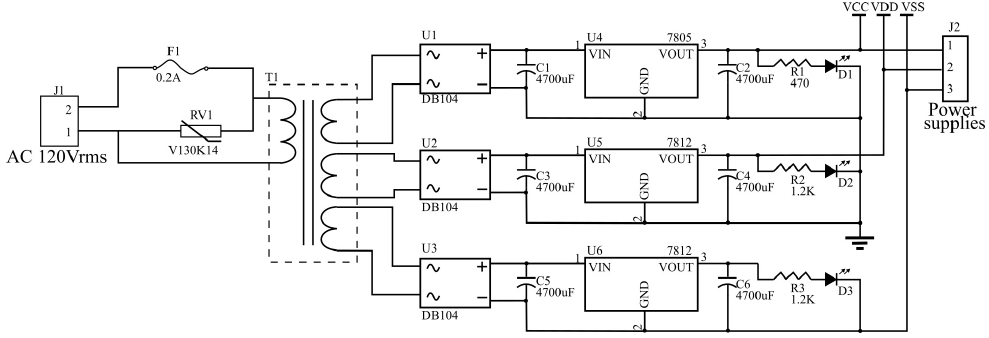
Figure 13. Power supply